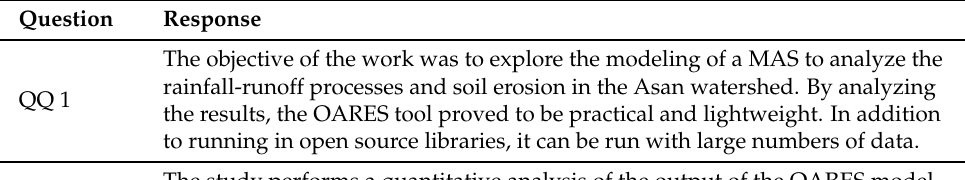
Table A6. Answers of quality questions about the work of Majumdar et al.